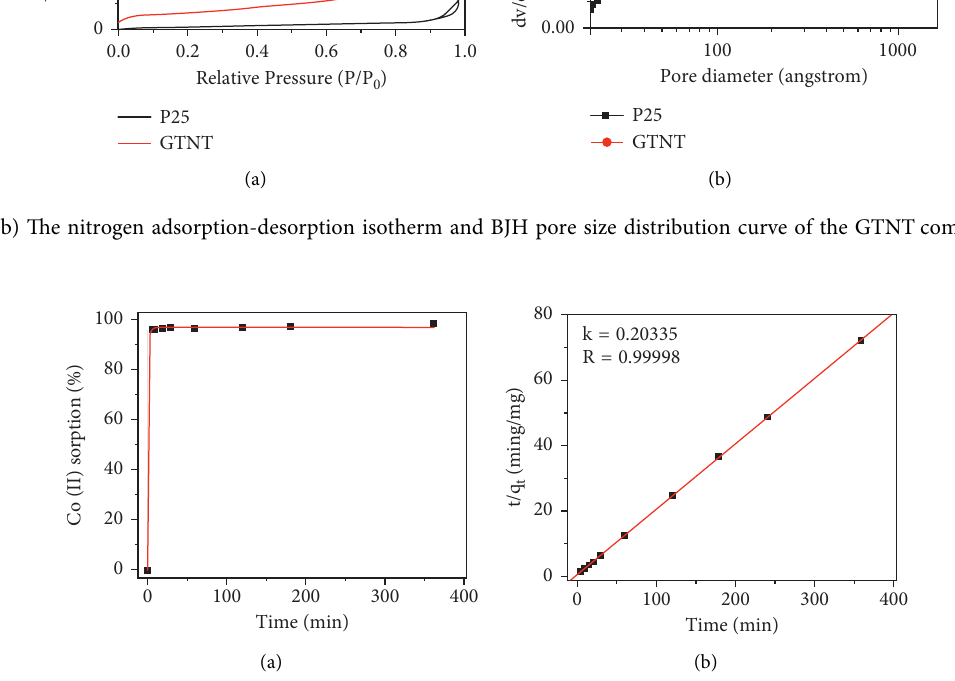
Figure 8: (a) Co(II) adsorption kinetics of the GTNT composites. (b) The corresponding pseudo-second-order fitting. Table 1: Kinetics parameters for Co(II) ions adsorption on the GTNT composites. Equations